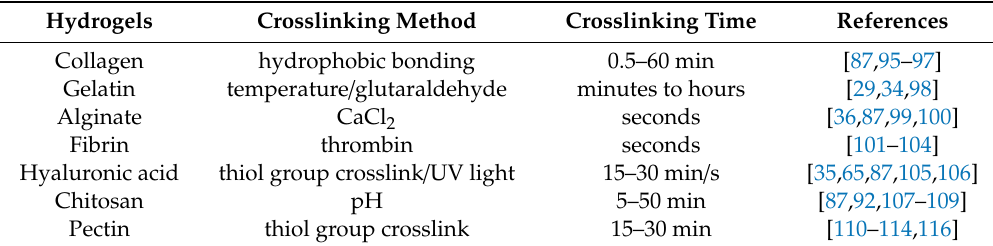
Table 2. Crosslinking methods and time of hydrogels commonly used for skin